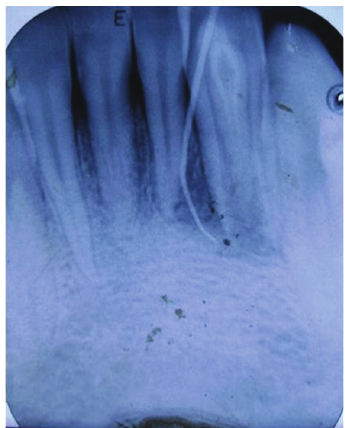
Figure4:RadiographshowingGPconepointingtotheinvolvement of 31 and